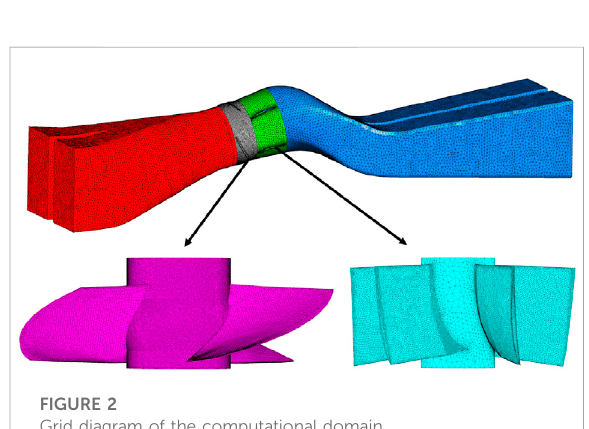
FIGURE 2 Grid diagram of the computational domain.